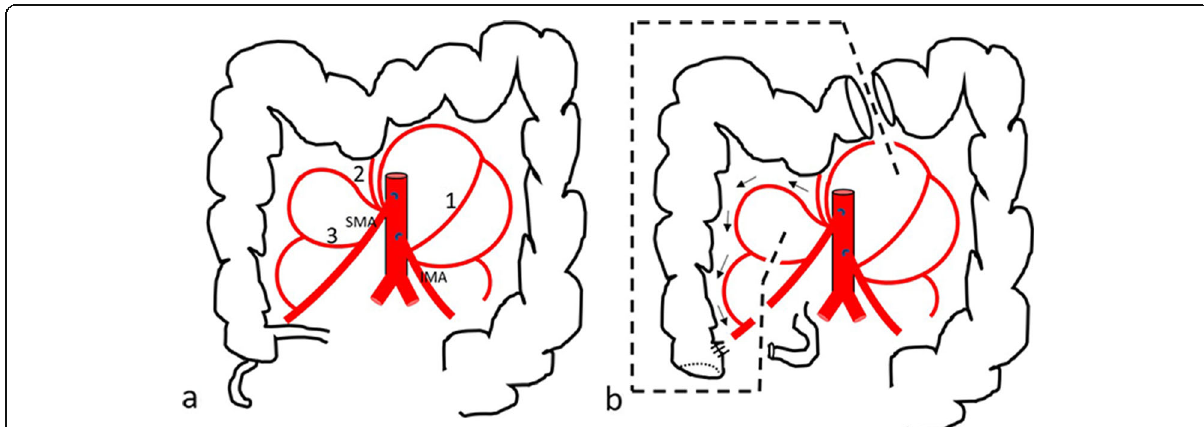
Fig. 3 Diagram demonstrating rare variation in the anatomy of middle colic artery (2%). a Superior mesenteric artery (SMA) giving origin for middle colic (2) and right colic arteries (3), while the inferior mesenteric artery (IMA) gives the left colic artery (1). The middle colic vessels (2) were multiple, short, and non-branching with interrupted continuity of marginal vessels at that point. b Boundaries of the right colonic flap (dashed line) based on the middle colic vessels after ligation of right colic vessels. Note: the appendix has been removed, followed by separation of the ileo-colic junction, while the gastrointestinal tract continuity will be restored by anastomosing the terminal ileum with the left colon. The dotted line in the cecum is marking for the site of anastomosis with the oesophagus in the